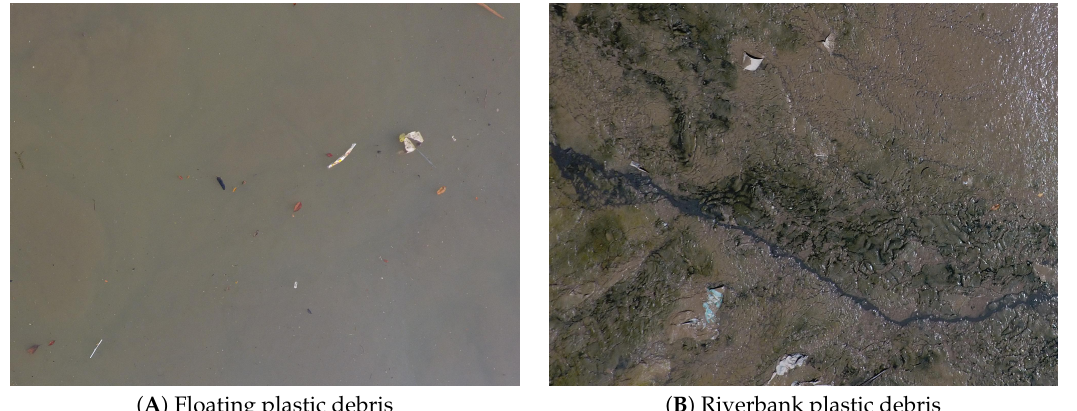
Figure 3. Examples of aerial images obtained during the aerial survey. ( A ) An example of an aerial image mainly showing floating plastic debris and some organic debris. ( B ) An example of an aerial image showing (partially) embedded riverbank